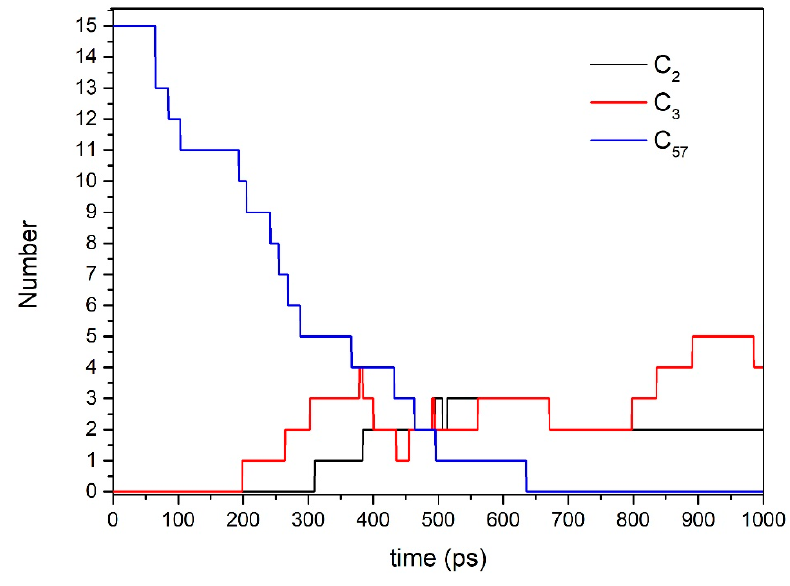
Figure 5. Time evolution of C 57 , C 2 , and C 3 .